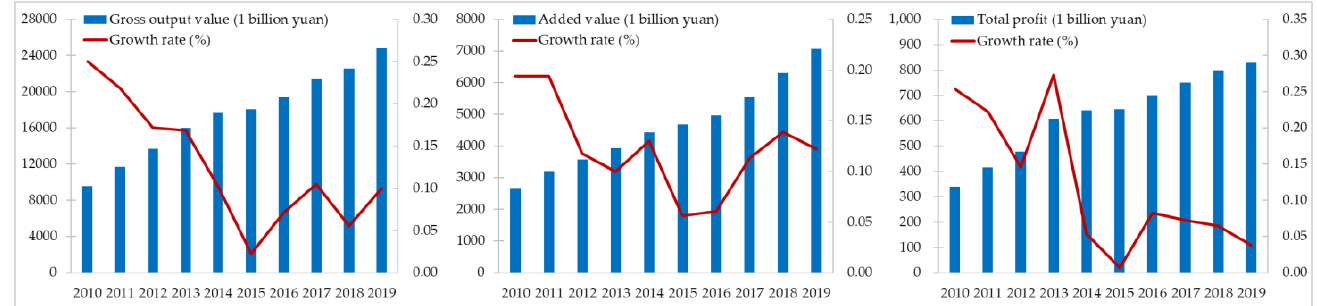
Figure 3. Annual change of economic output and growth rate on construction industry in China from 2010 to 2019.